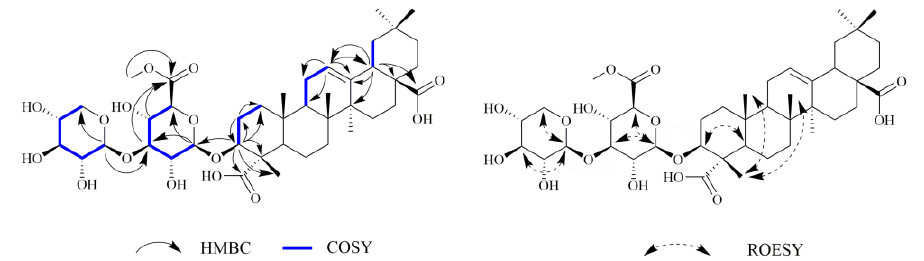
Figure 2. Key HMBC, COSY, and ROESY correlations of compound 2 .